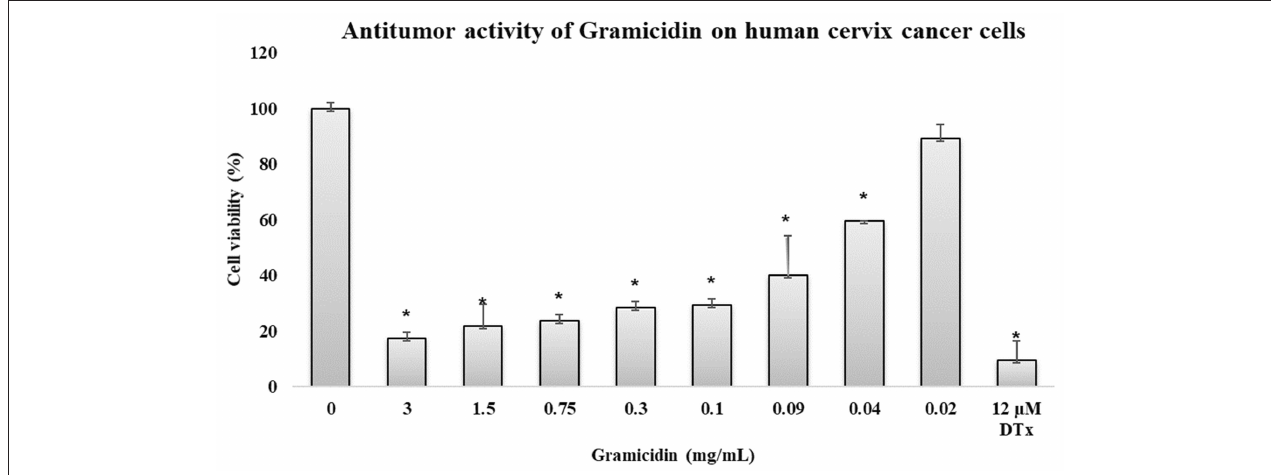
FIGURE 5 | Antitumor effect of gramicidin on HeLa cell line. Cell viability ( via MTT assay) after a 24-h exposure to serial dilutions of gramicidin 12 µ M docetaxel (DTX) as positive control of cytotoxicity. Antitumor effect was significant and dose-dependent as of 0.04 mg/mL gramicidin ( p < 0.0001). Asterisks indicate statistical difference with 0.02 mg/mL gramicidin ( α = 0.05).